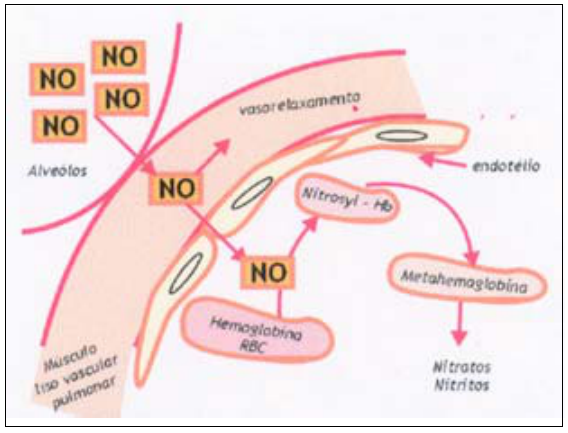
Fig. 1 (cid:150) Modo de a(cid:231)ªo do NO inalat(cid:243)rio. Ap(cid:243)s produzir vasodilata(cid:231)ªo pulmonar, o NO Ø inativado rapidamente pela hemoglobina dos eritr(cid:243)citos (RCB) Nitrosyl-hb: